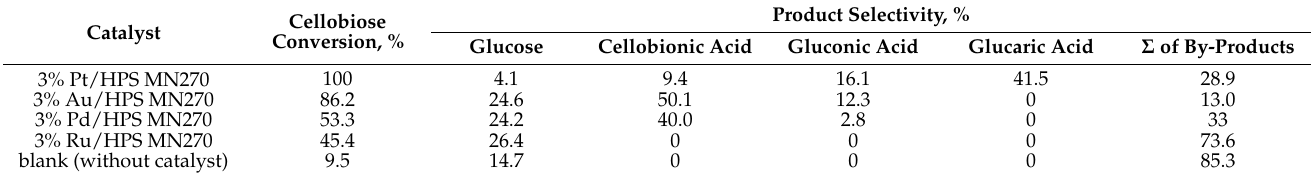
Figure 2. TEM images of catalyst samples and size distribution diagrams of metal-containing nanoparticles: ( a , b ) 3% Pt/HPS MN270; ( c , d ) 3% Pd/HPS MN270; ( e , f ) 3% Au/HPS MN270; ( g , h ) 3% Ru/HPS MN270. Table 4. Cellobiose conversion and selectivity values of the main reaction products depending on the nature of the catalyst active phase